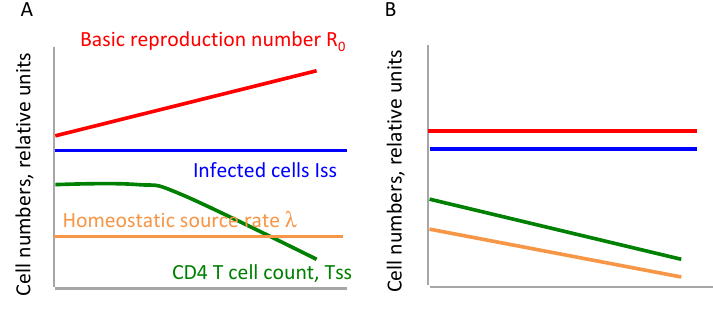
Figure 1. Two alternative hypotheses of the gradual decline of CD4 T cell count tested in the present article. Green line shows the quasi steady state level of CD4 T cells predicted by Equation (10) if ( A ) basic reproduction ratio R 0 changes due to gradual viral adaptation, ( B ) R 0 stays constant, but homeostatic source of CD4 T cells becomes weaker in time.